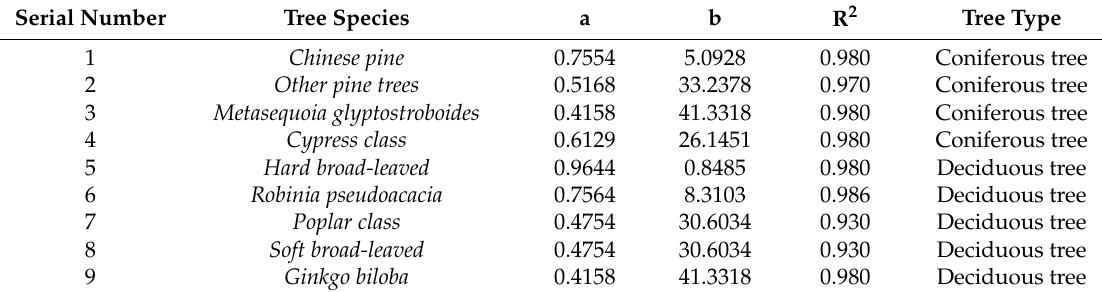
Table 1. Conversion model parameters between the aboveground biomass and stock volume for di ff erent tree species